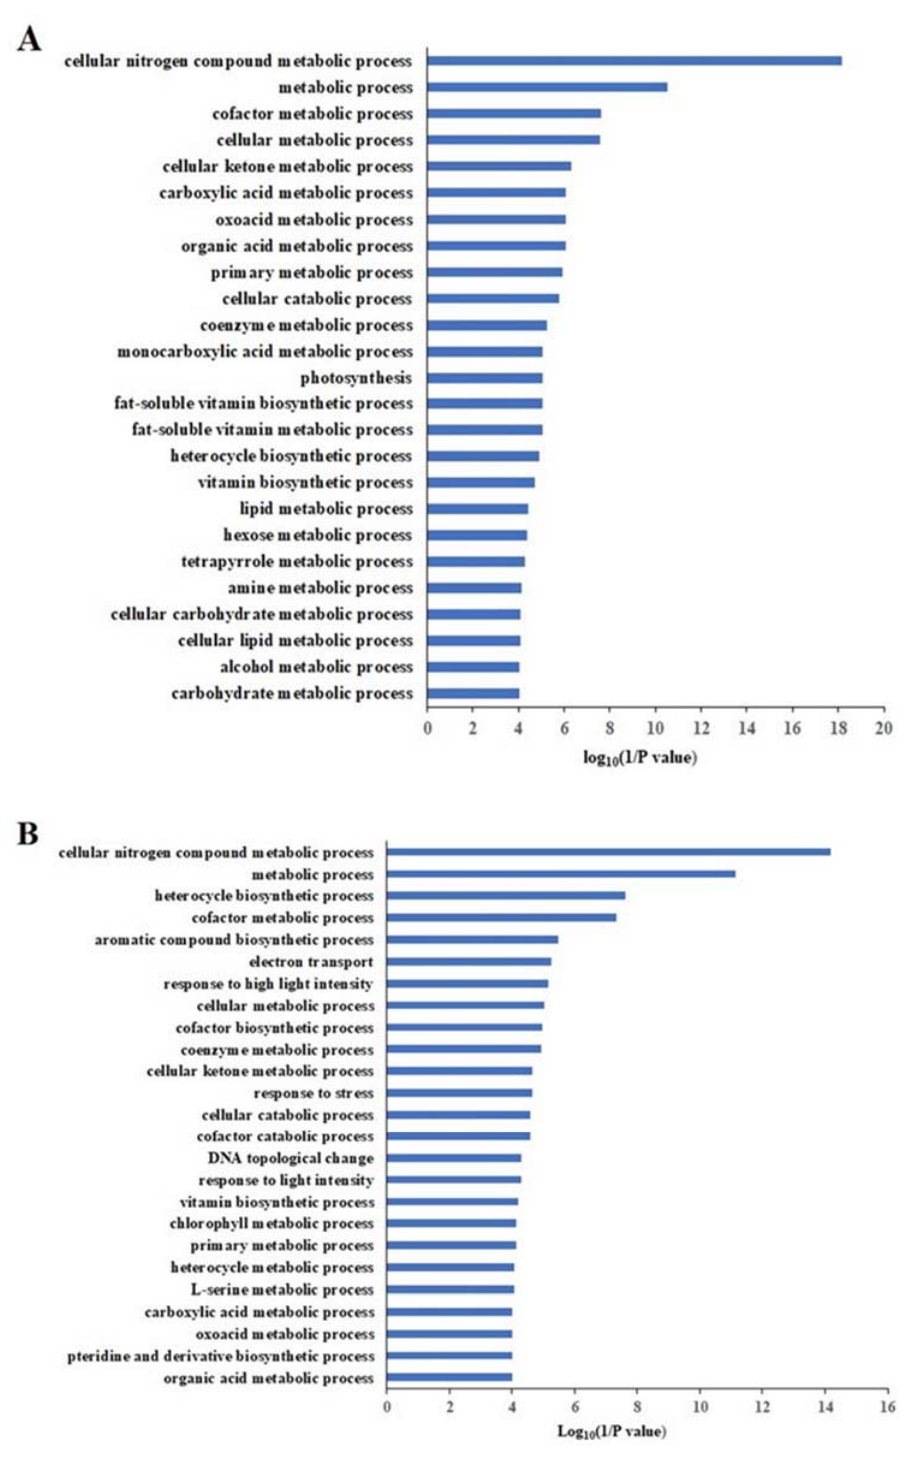
Figure 9. The Gene Ontology (GO) enrichment analysis of differential accumulated proteins (DAPs) in primary functional categorization of Atlas 66 ( A ) and Scout 66 ( B ) (biological process, p < 0.01).